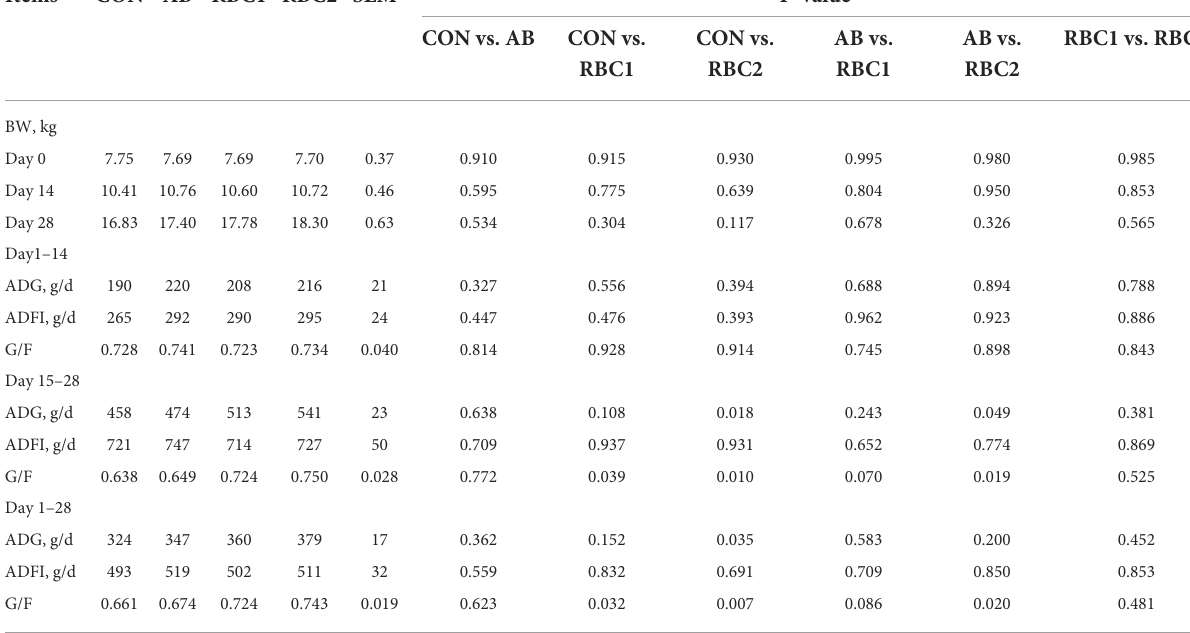
TABLE 2 Effect of dietary RBC and AB supplementation on the growth performance of weaning piglets.